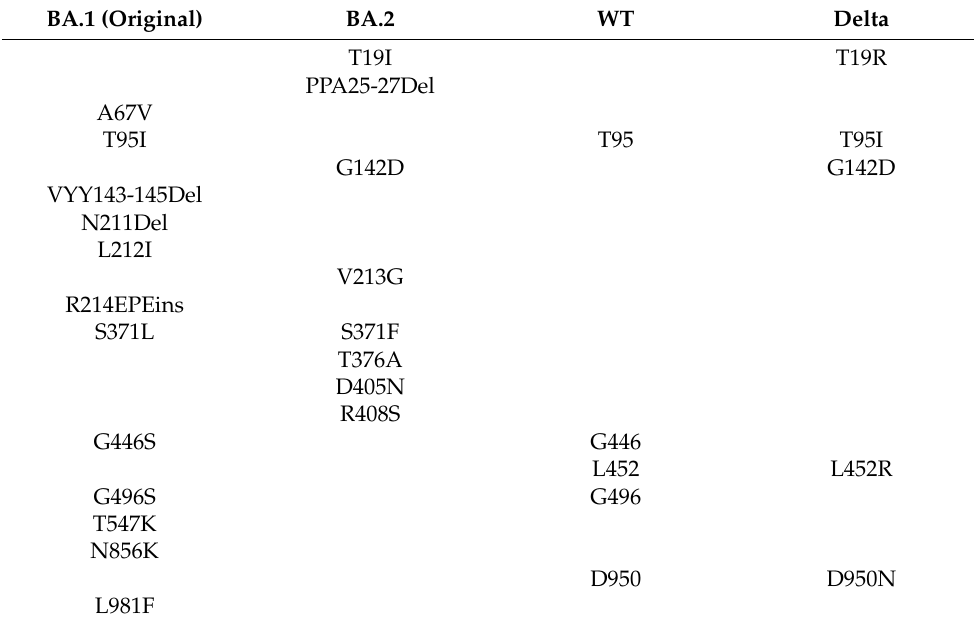
Table 2. Unique mutations in BA.1 and BA.2, together with a mutation in WT and Delta variants within the S-protein.